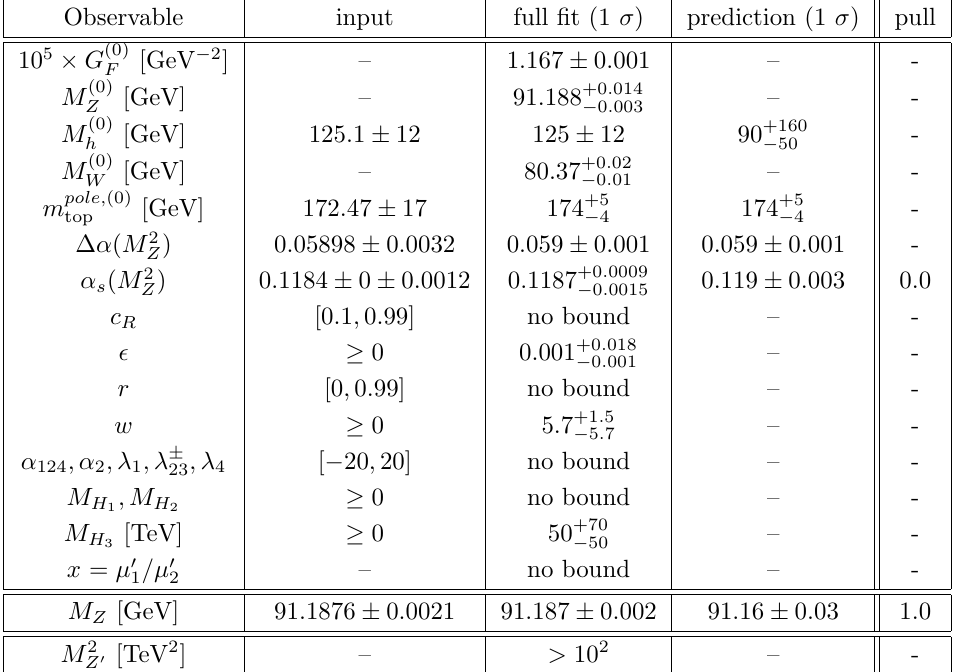
Table 4 . Same scenario of table 2, but with the constraint M W 0 > 10 TeV